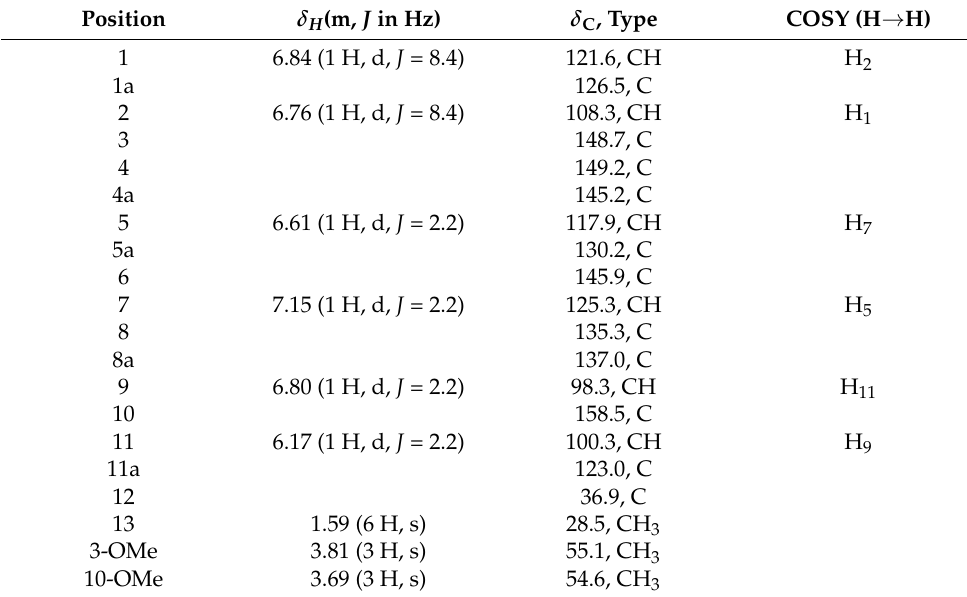
Table 2. NMR spectroscopic data for compound 1 (400 MHz, Methanol- d 4 ).